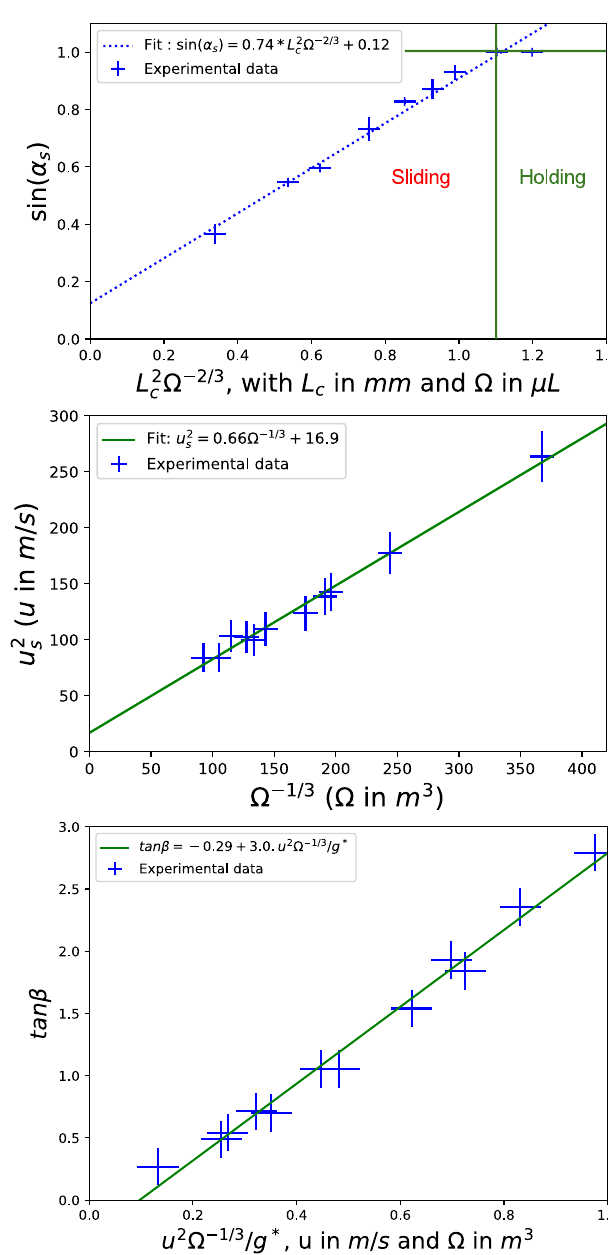
Fig. 8. (Top) scaling of sin a s ( a s the sliding angle for a drop) as a V (cid:2) 2 3 , with L function of L 2 c the capillary length for water under c normal conditions of pressure and temperature. Values of V range from 15 m L to 100 m L . A linear fi t (dashed line) to experimental data is expected, according to our theory. (Middle) experimental law for the relation between wind speed u s and drop volume V on an horizontal plane, law stemming from the competition between the drag force and the adhesion force. Linear correlation (red line) is consistent with our theoretical model. (Bottom) experimental results on the angle b taken by drops of given volume V under an horizontal wind u . Drops small enough are set on a vertical plane (we took V ¼ 20 m l or 25 m l so they can stay DESPITE GRAVITY). Then the wind blower is switched on, and blows horizontally with a speed u bigger than u s ( V ), the minimum value needed to dislodge the drop. As our model predicts, there is a linear law between tan b and the ratio u 2 V (cid:2) 1/3 / g *